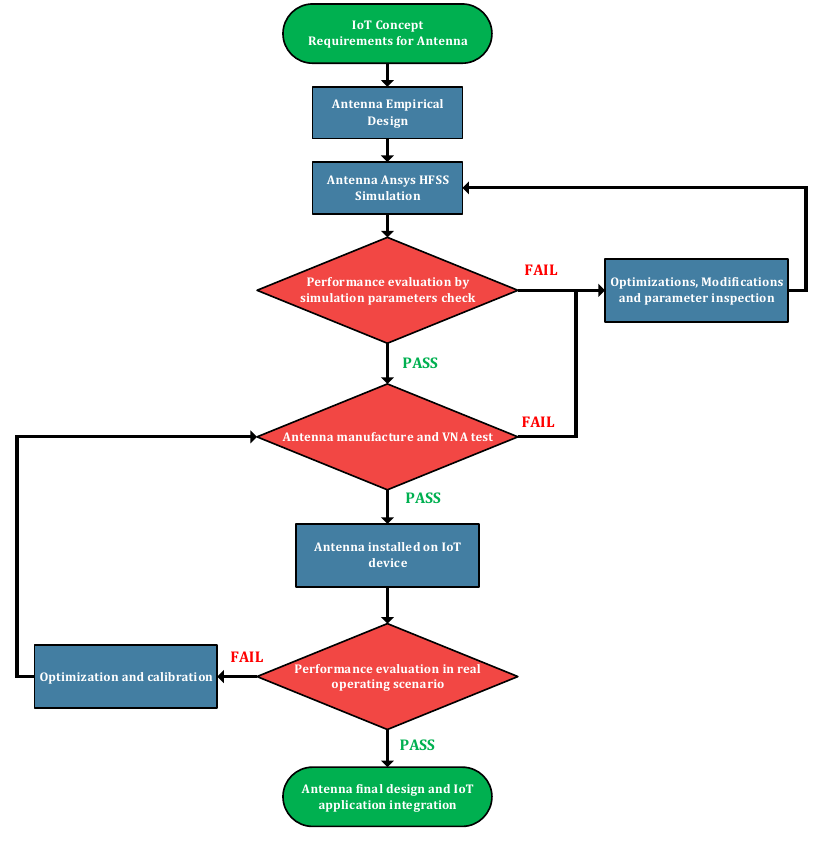
Figure 1. Design methodology.